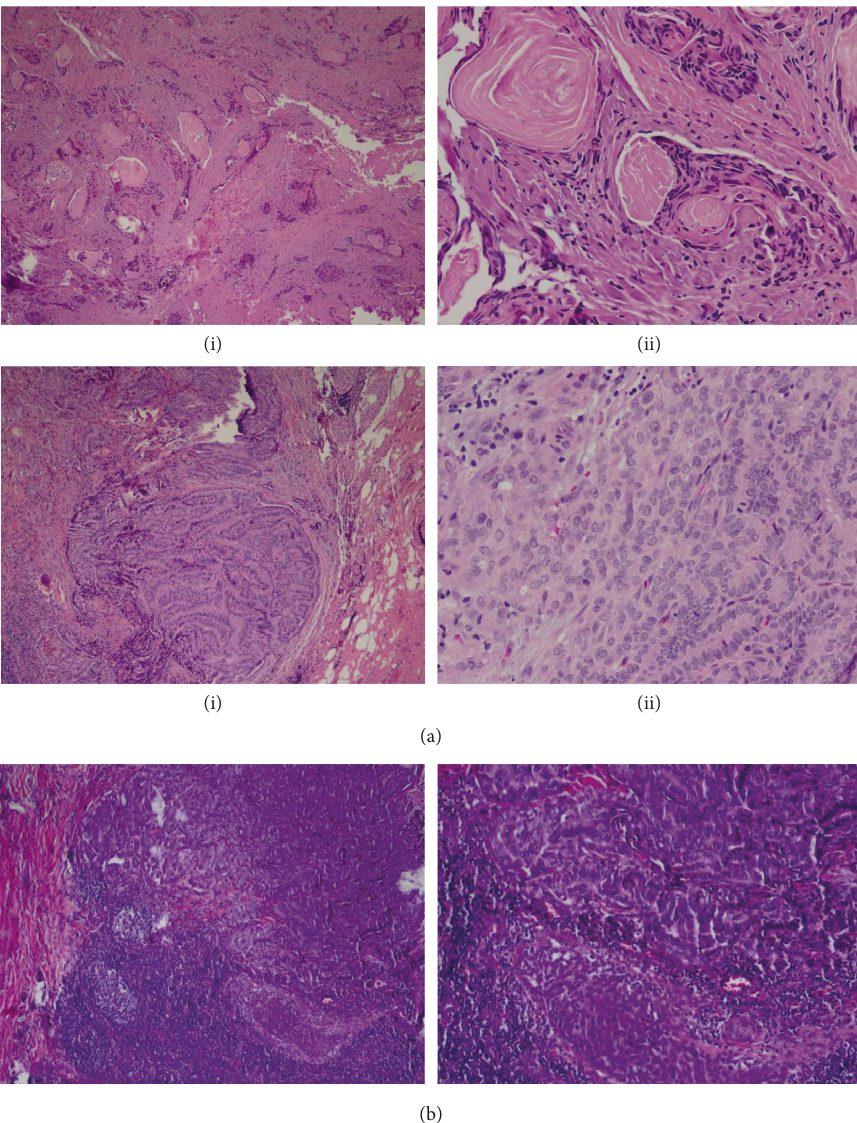
Figure 1: (a) H&E staining of the thyroid bed and paratracheal lymph node. Top row, from left to right: (i) squamous cell carcinoma in the thyroid bed; (ii) keratin pearls of squamous cell carcinoma in higher power. Bottom row, from left to right: (i) paratracheal lymph node showing papillary feature of thyroid cancer; (ii) tall cell areas showing mitotic figure in higher power. (b) From left to right, low power showing papillary thyroid cancer and squamous cell cancer in the same field adjacent to each